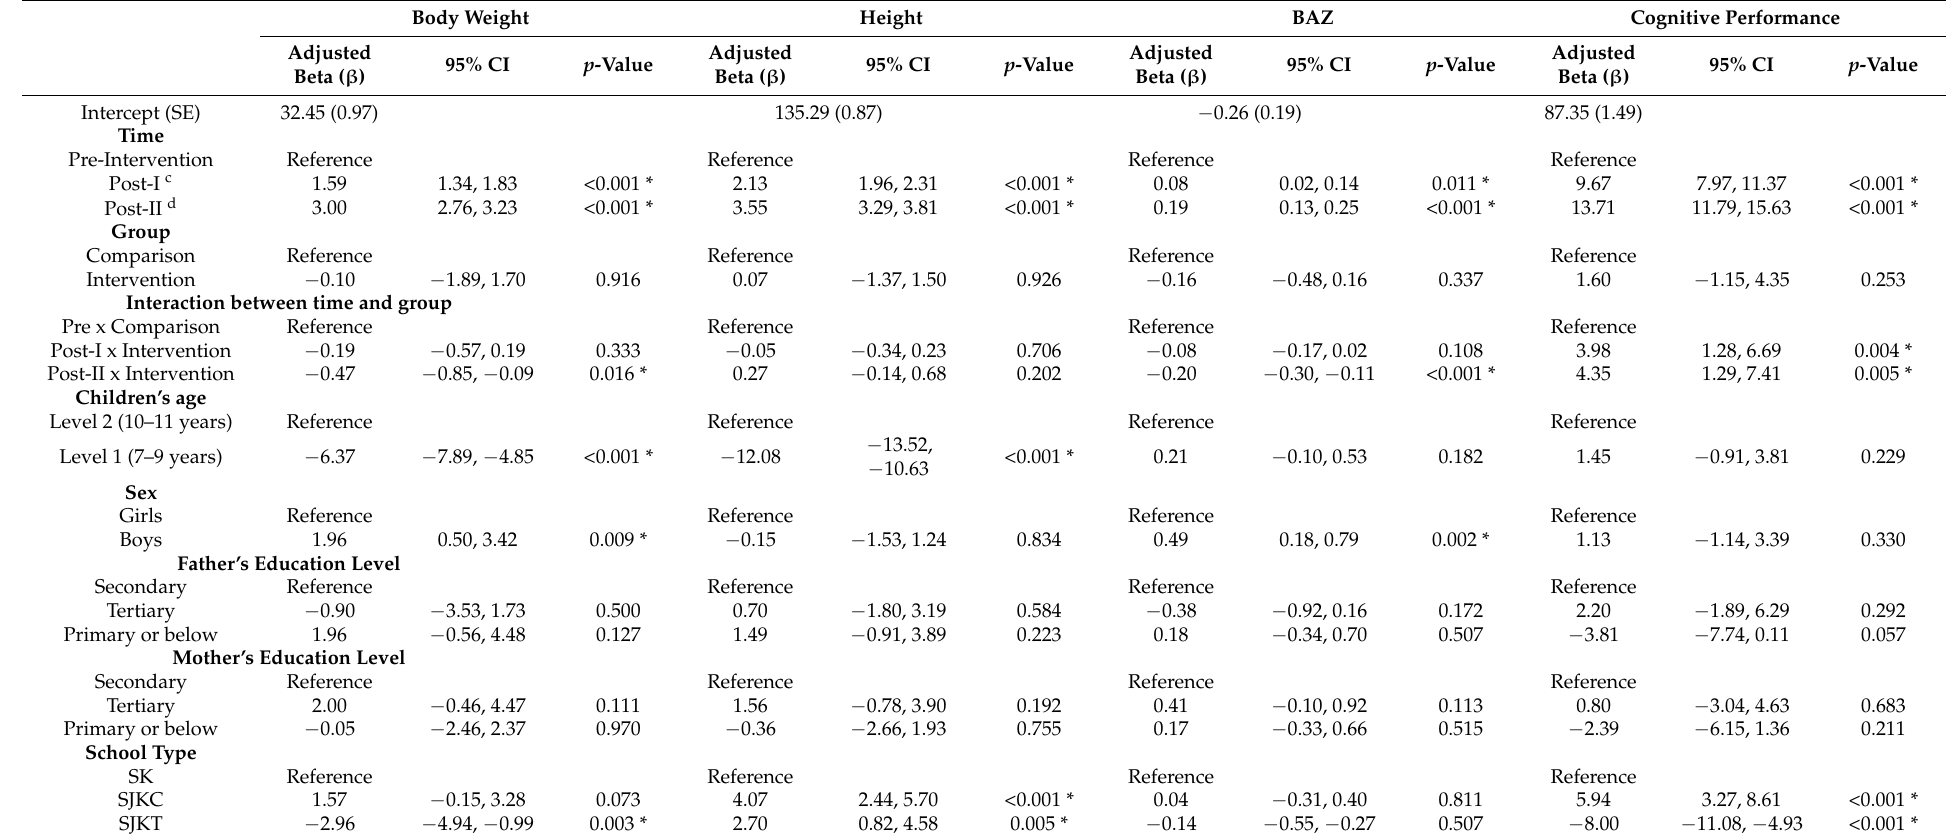
Table 4. Changes in nutritional status and cognitive performance, adjusted with covariates b